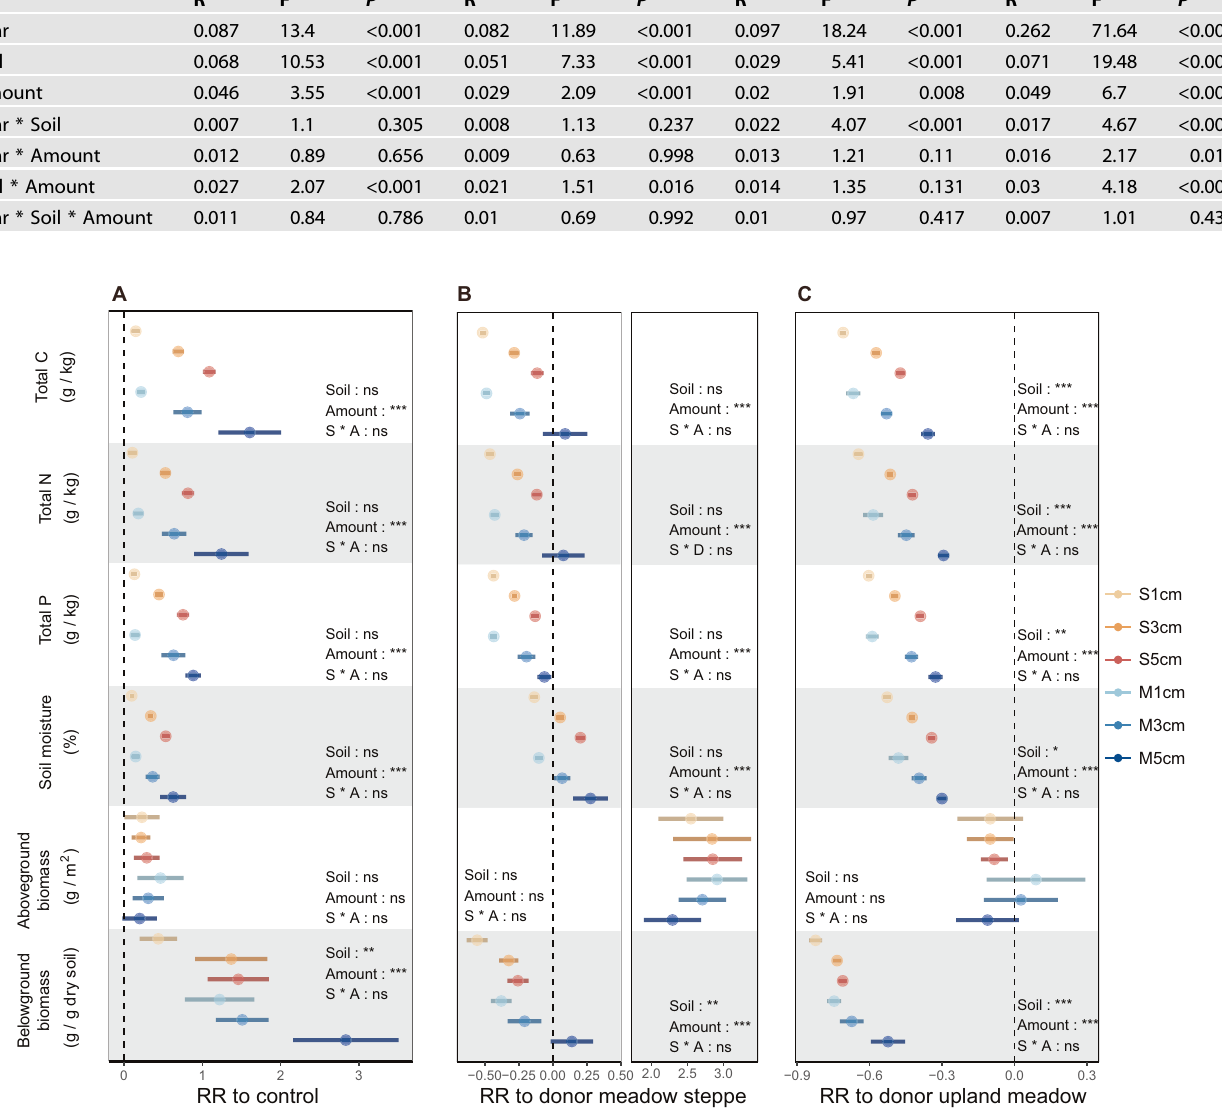
Fig. 3 Response ratio of soil and plant traits to control and donor sites. Response ratio of soil and plant traits to control ( A ), donor meadow steppe ( B ) and donor upland meadow ( C ). Error bars represent ±S.E. The category de fi nitions are as follows: S1cm, meadow steppe soil inoculation with 1 cm depth; S3cm, meadow steppe soil inoculation with 3 cm depth; S5cm, meadow steppe soil inoculation with 5 cm depth; M1cm, upland meadow soil inoculation with 1 cm depth; M3cm, upland meadow soil inoculation with 3 cm depth; M5cm, upland meadow soil inoculation with 5 cm depth. * P < 0.05; ** P < 0.01; *** P <